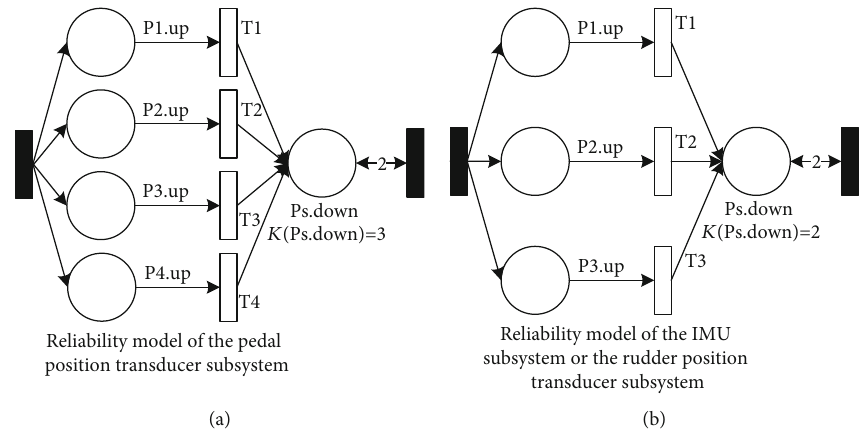
Figure 10: Petri net-based reliability model of the sensor subsystem.